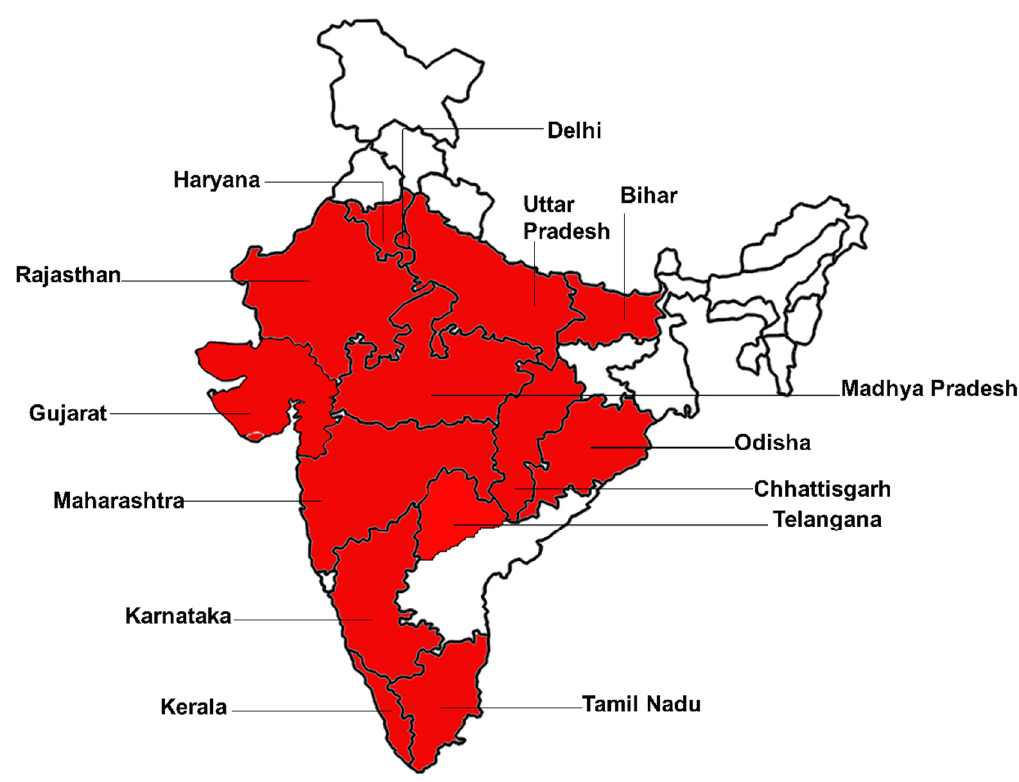
Figure 2. States with confirmed cases of black fungus after COVID infection in India. Red color indicates states in India with reported cases.